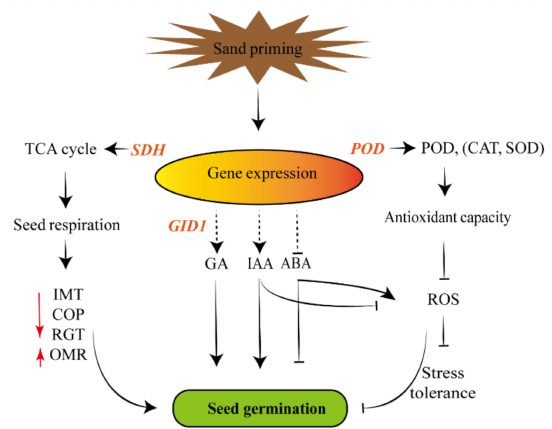
Figure 4. The regulatory mechanism of promotion of sand priming to seed germination in Pinus massoniana . Sand priming might enhance the relevant gene expression ( GID1 , POD , SDH , etc.). These genes might further affect the endogenous hormones level, antioxidant capacity and seed respiration. The enhancement of GA, IAA, low ROS and ABA might contribute to seed germination of Pinus massoniana . Simultaneously, it would enhance the stress tolerance, but it should be verified in follow- up research. SDH: succinate dehydrogenase; POD: peroxidase; CAT: catalase; SOD: superoxide dismutase; TCA: tricarboxylic acid; GID1: Gibberellin metabolism protein gene; GA: gibberellin; IAA: indole-3-acetic acid; ABA: abscisic acid; IMT: increased metabolism time; OMR: oxygen metabolism rate; COP: critical oxygen pressure; RGT: relative germination time; ROS: reactive oxygen